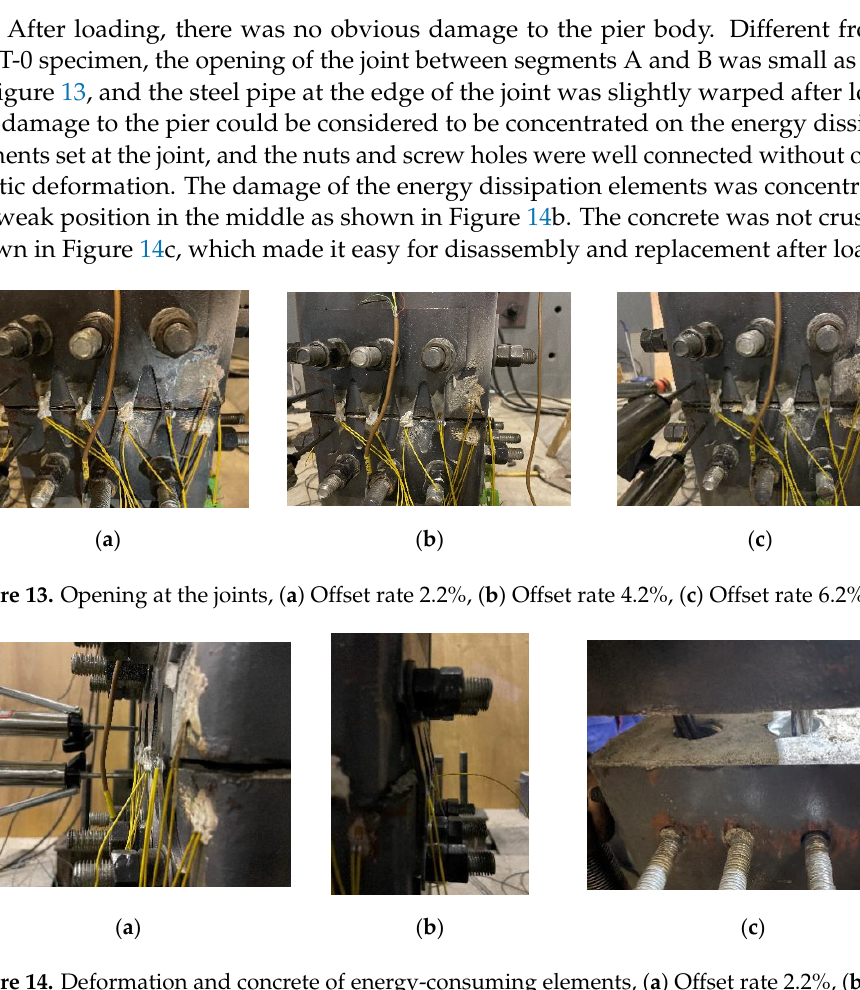
Figure 12. CFST-F loading diagram, ( a ) Before loading, ( b ) After loading.